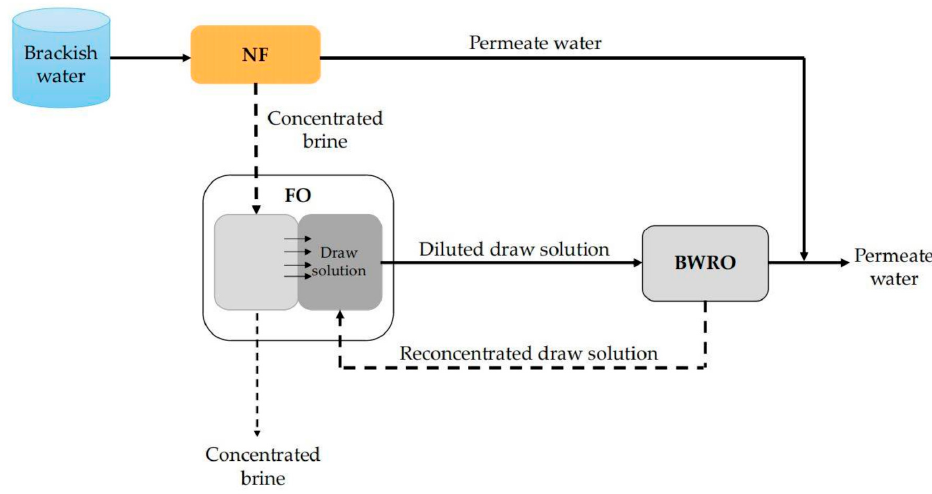
Figure 11. Schematic diagram of NF–FO–BWRO system.